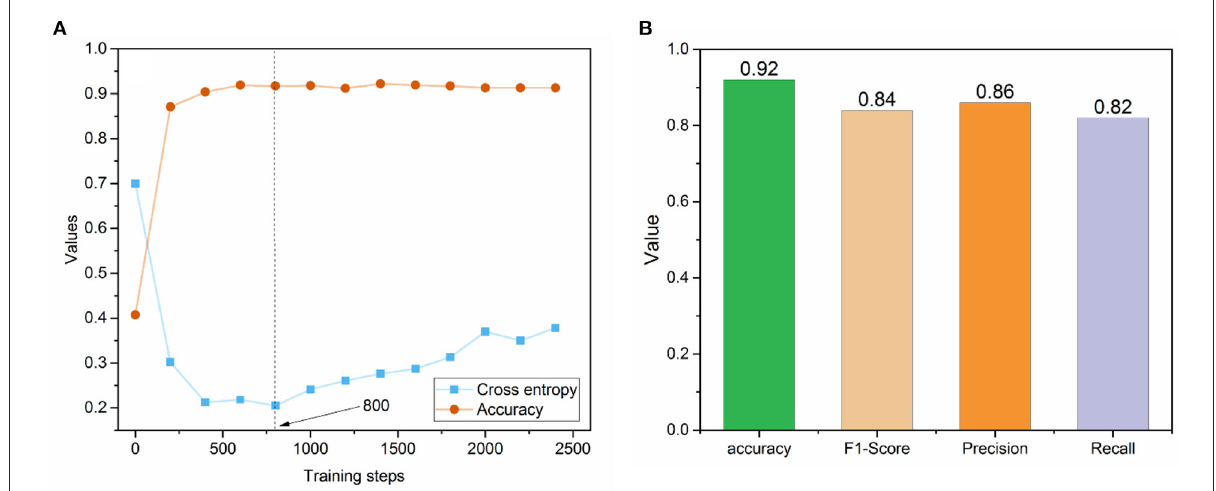
FIGURE3 (A) The trend of cross-entropy loss and accuracy across the different training steps in the fine-tuned BioBERT model; (B) Prediction performance metrics of the optimized fine-tuned BioBERT model on the test